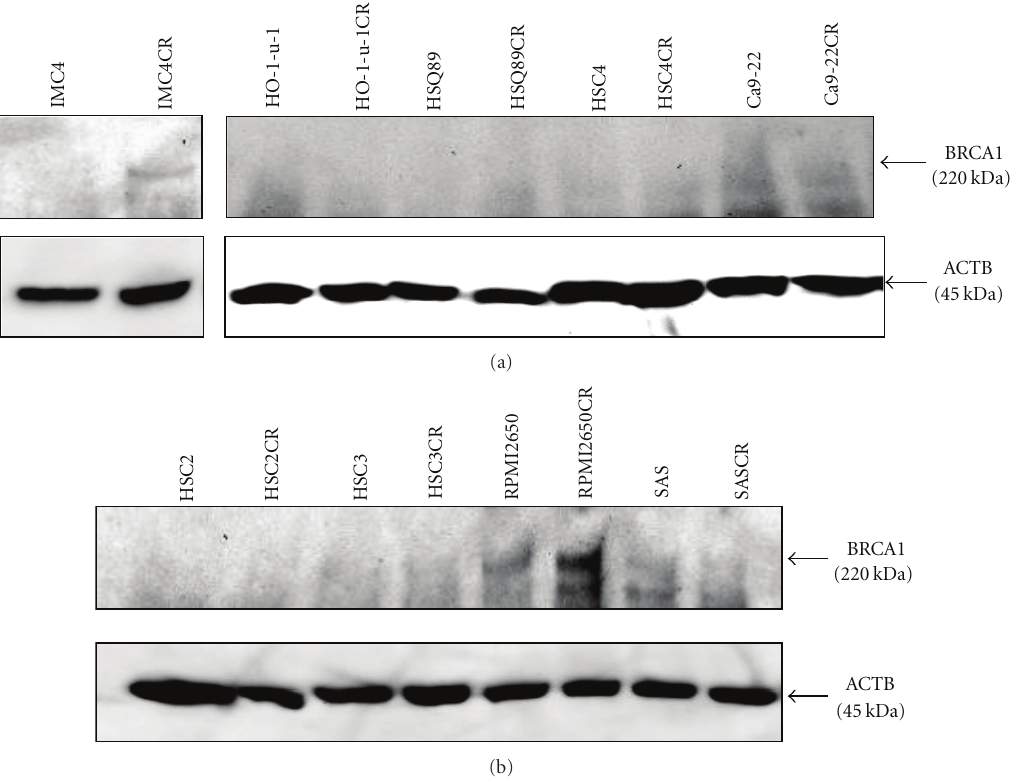
Figure 2: Western blot analysis of BRCA1 in HNSCC cell lines and their derived CDDP-resistant (CR) cell lines. Marked upregulation of BRCA1 (220kDa) was observed only in the RPMI2650CR cell line. Beta actin (ACTB) was used as an internal